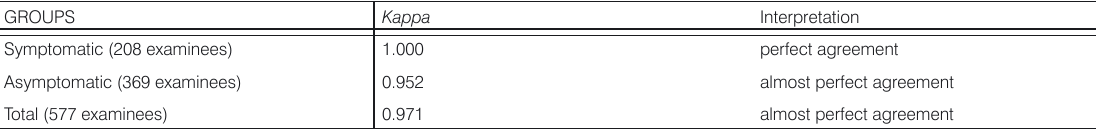
Table 2. Agreement of the EIA method with the reference standard.